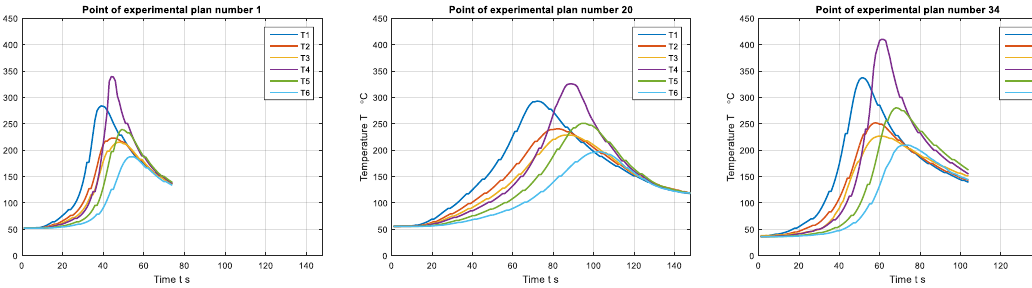
Figure 6. Diagram of temperature at the points of the experimental plan number: 1, 20, and 34 [22].